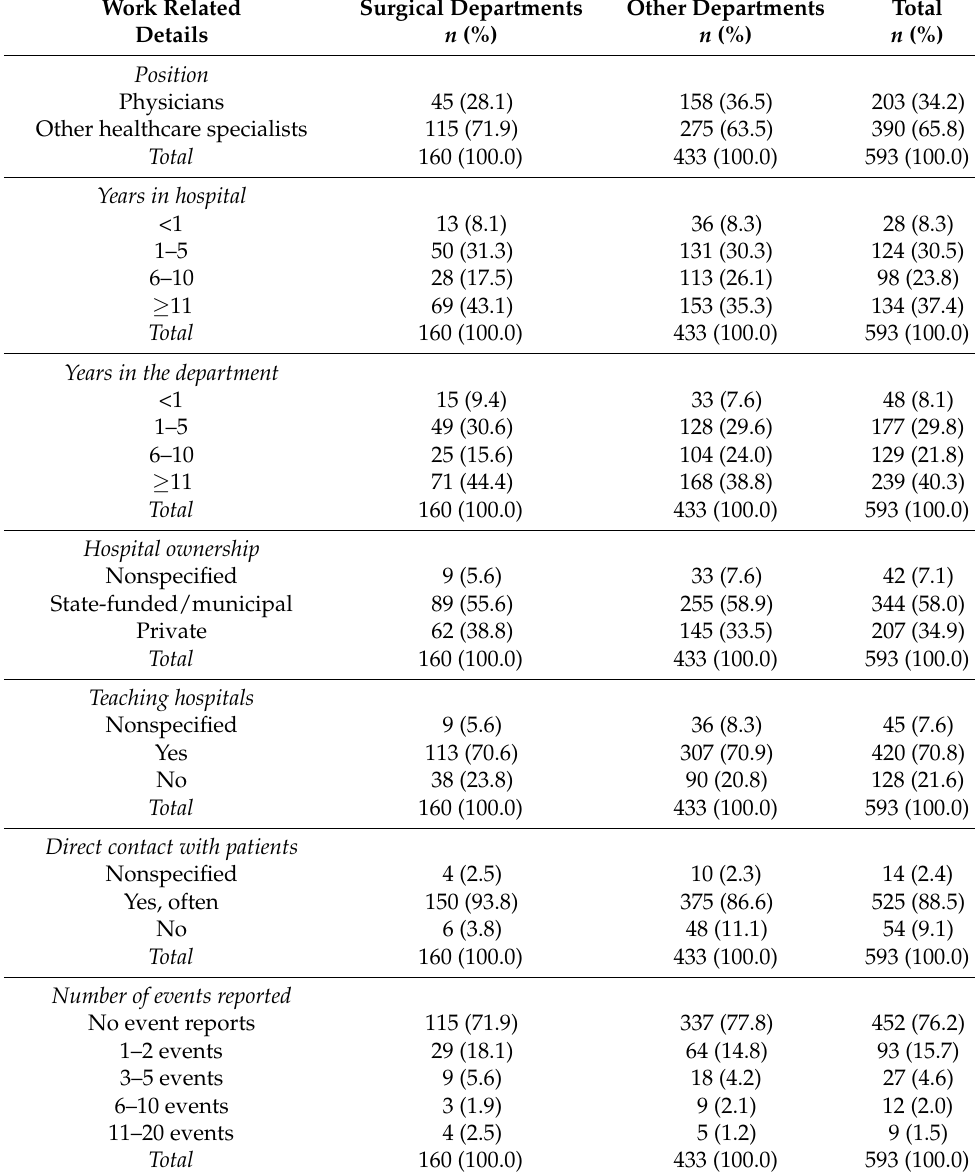
Table 1. Work-related characteristic of the study participants ( n = 593) based on the HSOPSC